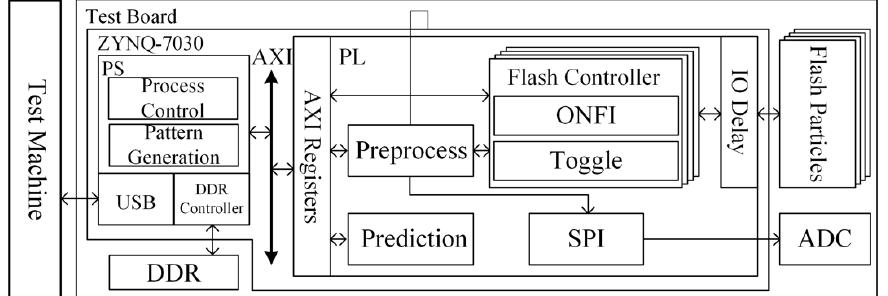
Figure 4. Overview of the Flash test platform.